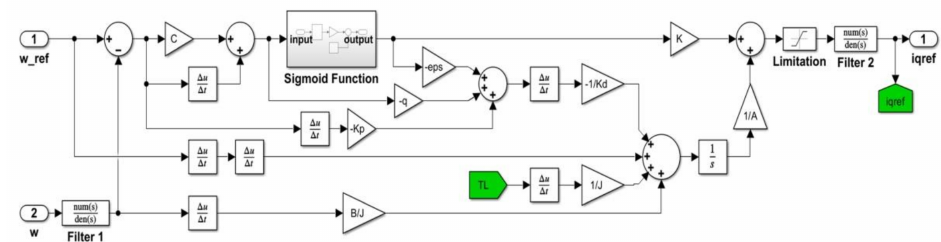
Figure 15. Block diagram of the MATLAB/Simulink implementation for the SMC speed